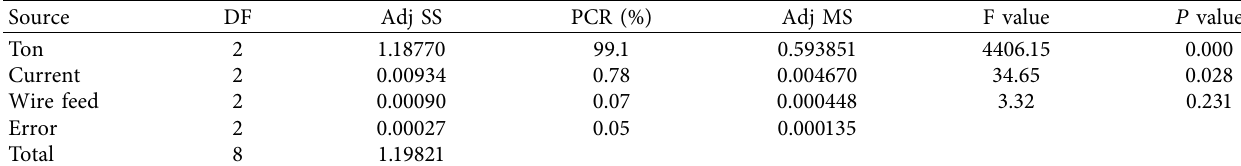
Table 5: ANOVA table for R